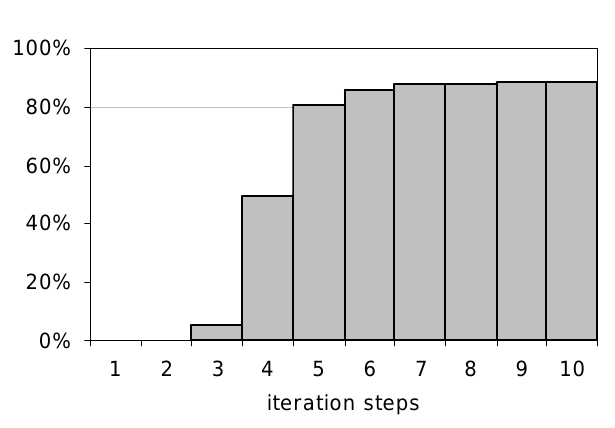
Fig. 1. Retrieval statistics for February 1998 with the settings of Table 1. 11.4% of the retrievals do not converge after 10 iteration steps.